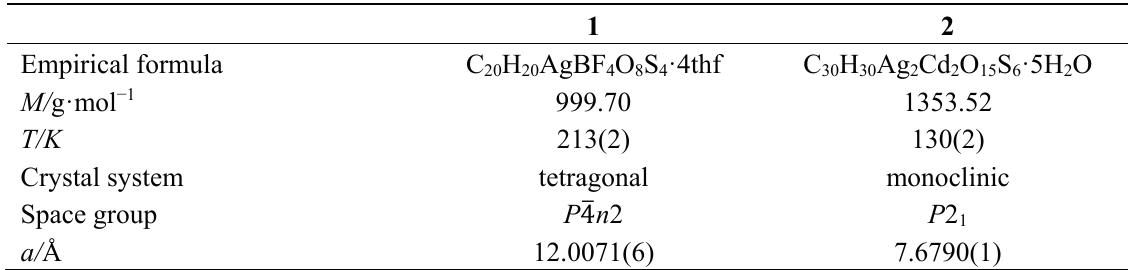
Table 3. Data collection, structure solution, and refinement details for compounds 1 and 2